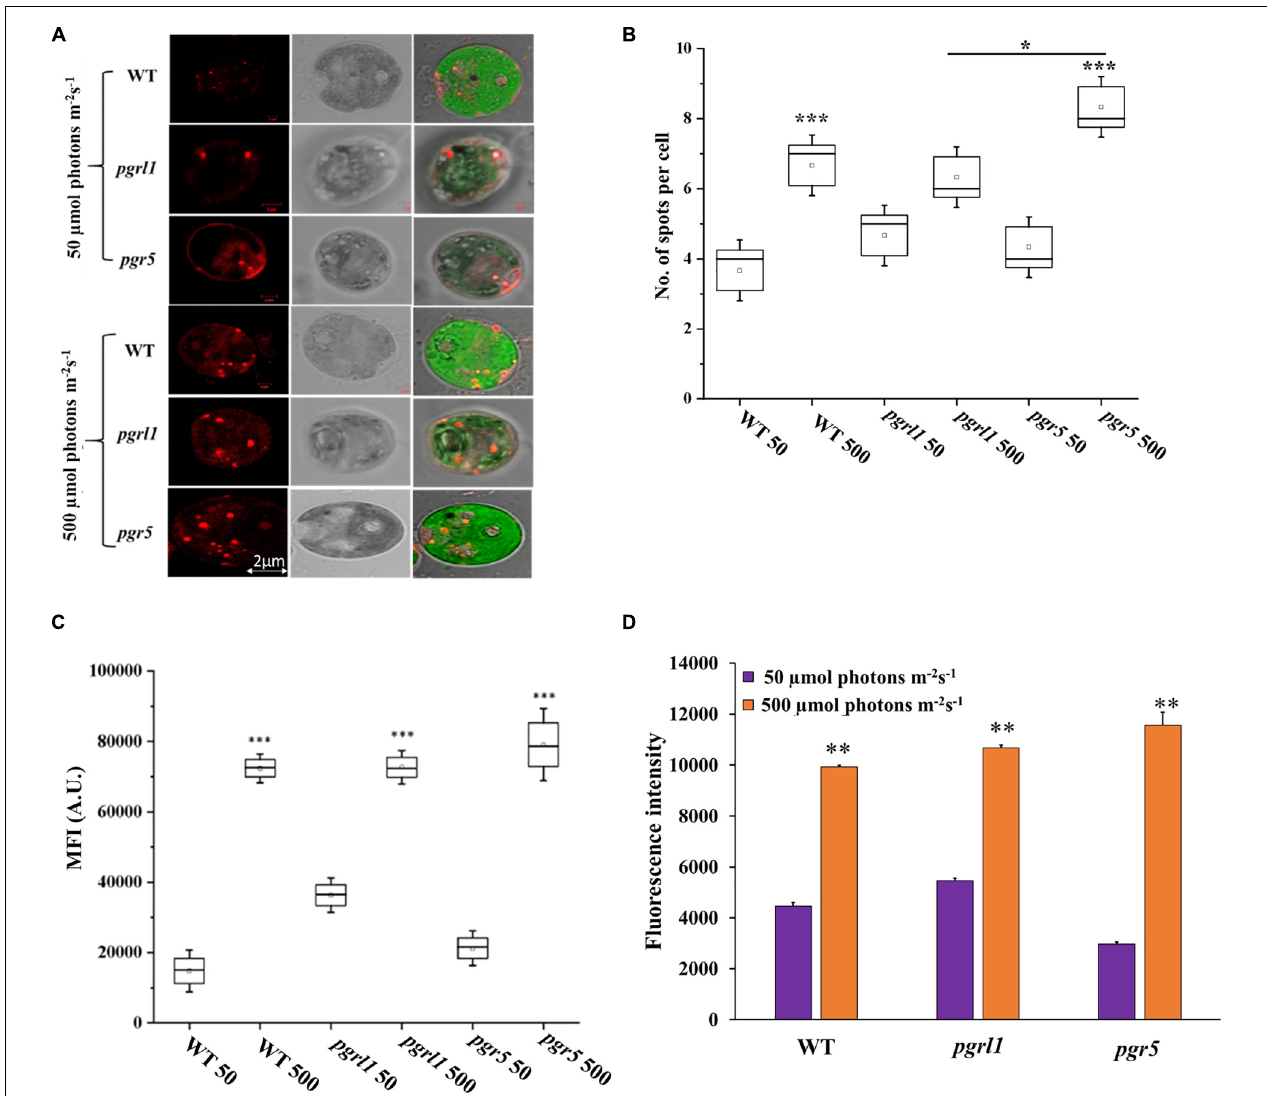
FIGURE 5 | Lipid droplets were identified through confocal microscopy and FACS analysis. (A) Cells grown under normal (50 µ mol photons m − 2 s − 1 ) and high (500 µ mol photons m − 2 s − 1 ) light conditions were stained with Nile Red (5 µ M/mL) for lipid droplets in C. reinhardtii strains, WT , pgrl1, and pgr5 . The images were collected with three individual measurements for all the conditions. Bars = 2 µ m. (B) Quantification of number (quantification was performed from single cell with three individual cultures) and (C) fluorescence intensity of lipid droplets as shown. Box plots indicate the medians, means, and quartiles. Statistical significance was analyzed using one-way ANOVA with Tukey test, and the p -value obtained is indicated ( ∗∗∗ p < 0.001, ∗ p < 0.05). Bars = 2 µ m. (D) Fluorescent activated cell sorter (FACS) analysis was carried out for lipid accumulation with BD Fortessa, United States. WT, pgrl1 and pgr5 50; WT, pgrl1 and pgr5 500, represents 50 and 500 µ mol photons m − 2 s − 1 . All the measurements were done with the PE-A filter. The analysis showed mean fluorescence value to compare light conditions of normal (50 µ mol photons m − 2 s − 1 ) and high (500 µ mol photons m − 2 s − 1 ). An unstained condition was kept to minimize the chlorophyll autofluorescence from cells. Cells were stained with Nile Red (NR), and measurements were done after incubated for 20 min under dark at room temperature (RT). The measurements were repeated with three individual cultures, and error bars represented the mean ± SD ( n = 3). Statistical significance was analyzed using one-way ANOVA with Tukey test and p -value obtained are indicated ( ∗∗∗ p < 0.001, ∗∗ p < 0.01, ∗ p < 0.05). Bars = 2 µ